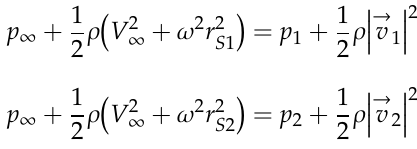
Figure 6. Illustration of the vortex at a small face of blade surface: the faces are intentionally enlarged in order to be displayed clearly.